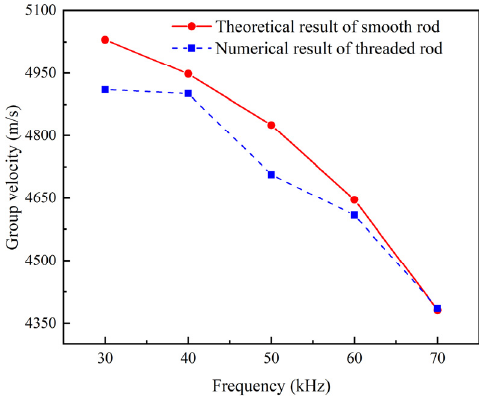
Figure 7. Group velocity under different excitation frequencies.